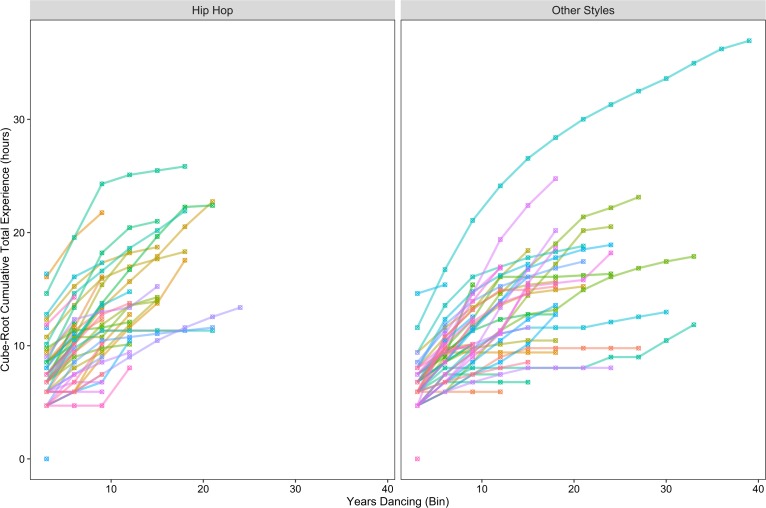
Accumulated dance experience by age.Accumulated hip hop and other dance style experience (cube-root of total accumulated hours) as a function of number of years dancing each type of dance (binned by three-year increments). Each colored line segment indicates the accumulated experience of a specific participant.